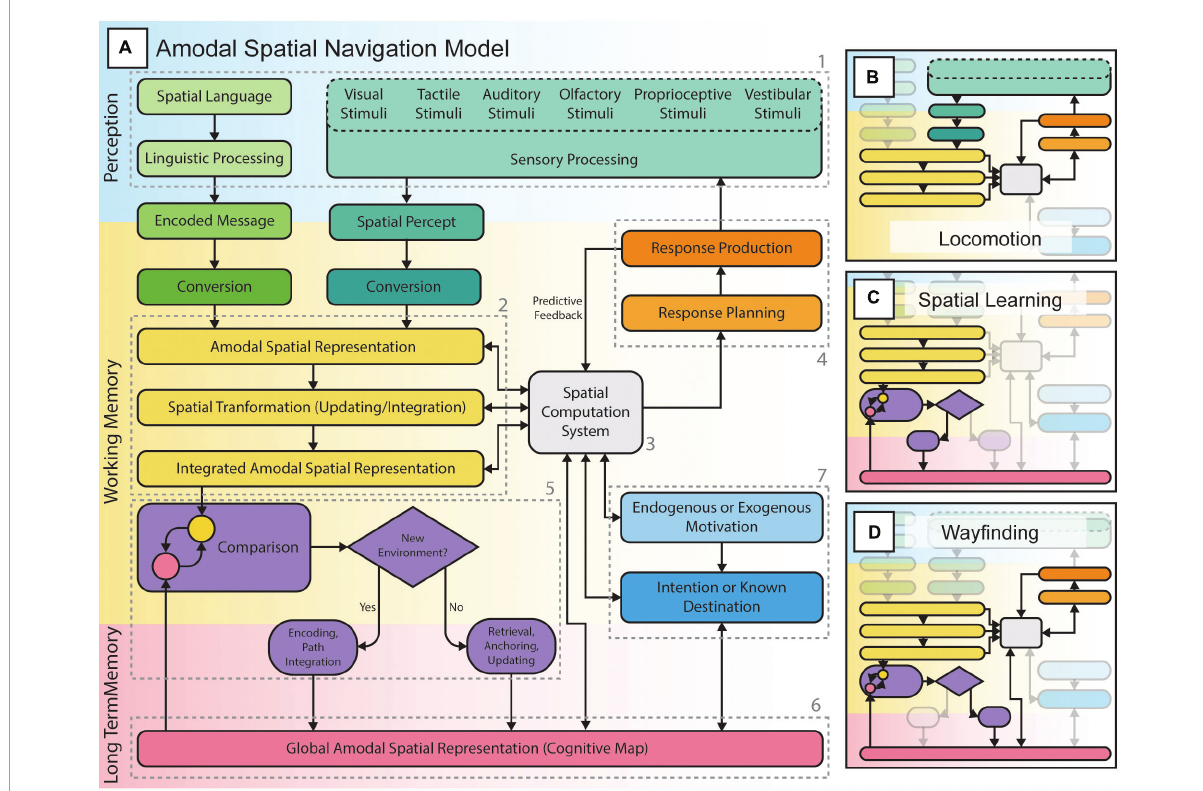
FIGURE5 The amodal spatial navigation model including locomotion, spatial learning, and wayfinding. (A) Spatial navigation from perception to action, through various spatial computations, planning and execution of responses (actions such as movements and/or attentional allocation to sensory stimuli) according to endogenous or exogenous goals, and the formation and/or use of internal spatial representations (e.g., cognitive maps) to orient oneself in the environment. (B) Locomotion or “response-based” navigation consists of a sensorimotor loop that allows the individual to negotiate his path in the environment while considering the presence of obstacles or changes in the ground surface and level. The individual perceives the environment through sensory channels, extracts spatial information and uses it to plan and execute actions. These will then lead to a change (i.e., a new position or viewpoint) in the perceived environment followed by the planning of subsequent actions. This loop is involved in all forms of spatial navigation, including spatial learning and wayfinding tasks. (C) Spatial learning is the process of encoding an environment during locomotion (e.g., exploration): the individual integrates various spatial representations and forms a more global cognitive map to be stored in long-term memory. Such spatial representations can either be survey or route knowledge. (D) Wayfinding or “cognitive map-based” navigation is the process of retrieving a specific cognitive map and constantly relating it to the perceived environment during locomotion in order to reach known locations while staying oriented in the